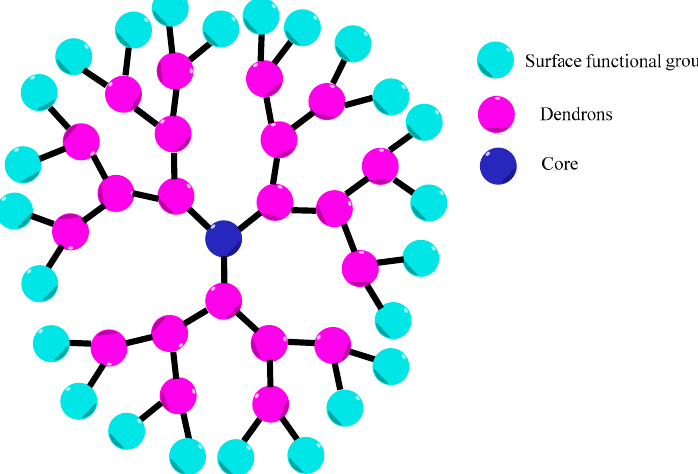
Figure 1. Dendrimer general structure.